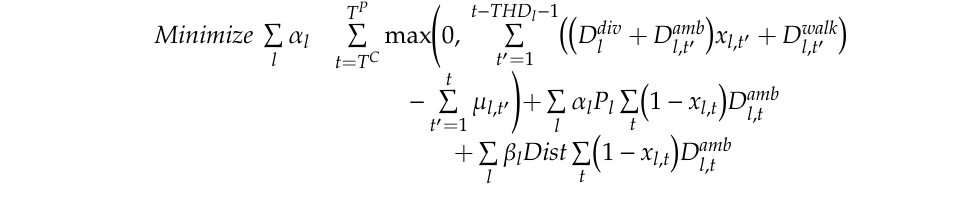
Dist : Average transport time required to divert patients P l : Average tardiness of diverted patients D div : Average number of diverted patients of type l from other hospitals l